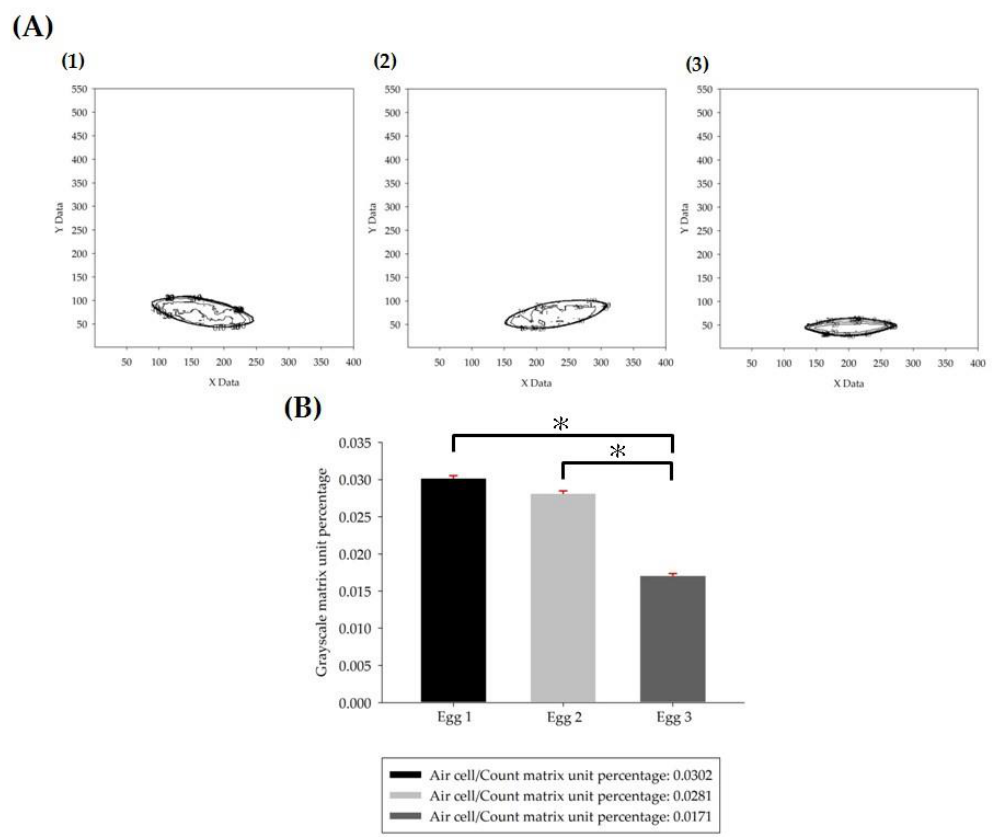
Figure 6. ( A ) Results for a complete separation of the air cell from the inner egg for a stratification analysis of the data visualization images in the axial plane direction. ( B ) Results of the quantitative analysis and statistics of the percentage of gray-scale signals in the separated air cell of each egg in a 220,000 count matrix of gray-scale units in the axial plane direction. The p values less than 0.05 are summarized with one asterisk.